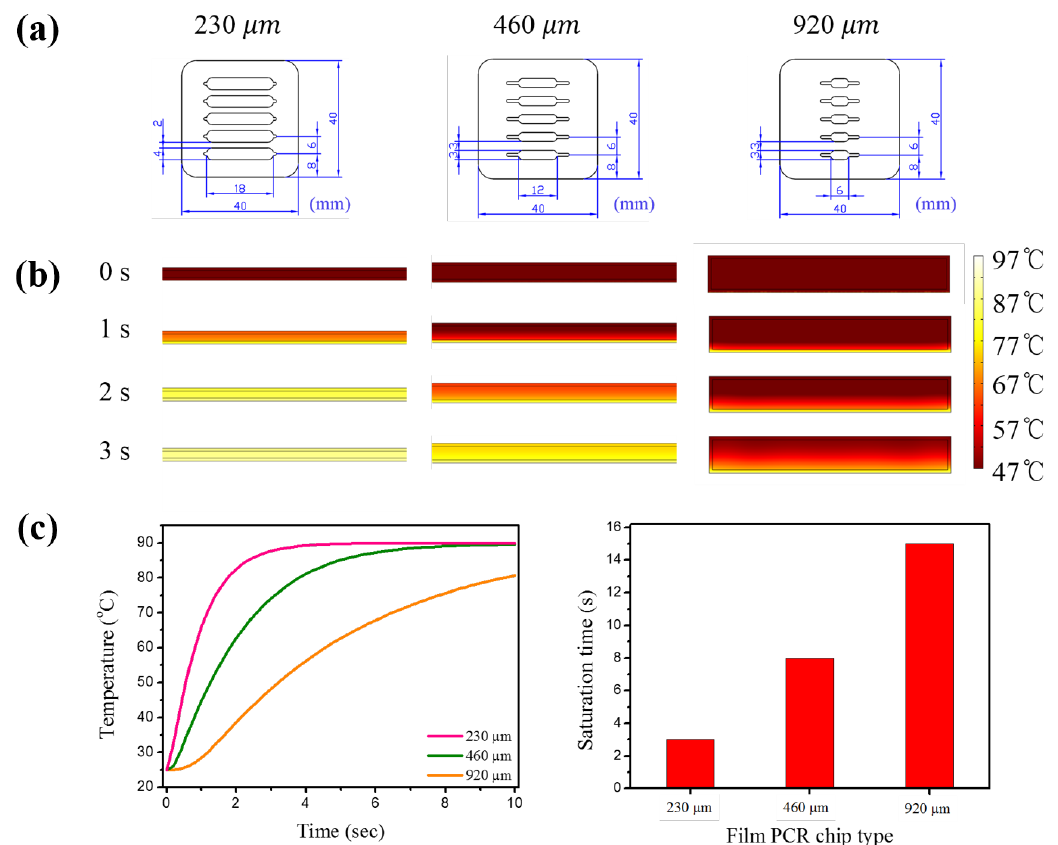
Figure 3. ( a ) The dimension of three type designed film PCR chip which contains the various width, length, and height (18 × 4 mm with 230 µm, 12 × 3 mm with 460 µm, and 6 × 3 mm with 920 µm) with same total volume of 20 µL; ( b ) the heat transfer simulation for 3 s in each designed film PCR chip by COMSOL software; and ( c ) the calibration curve for temperature and saturation time in each film PCR